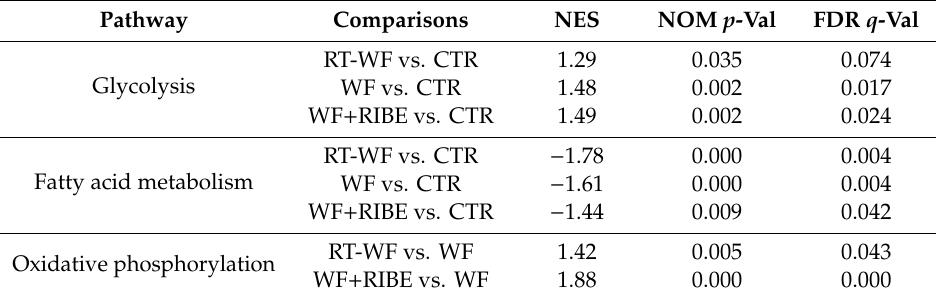
Table 1. Metabolic pathways revealed by GSEA analysis in MDA-MB-468